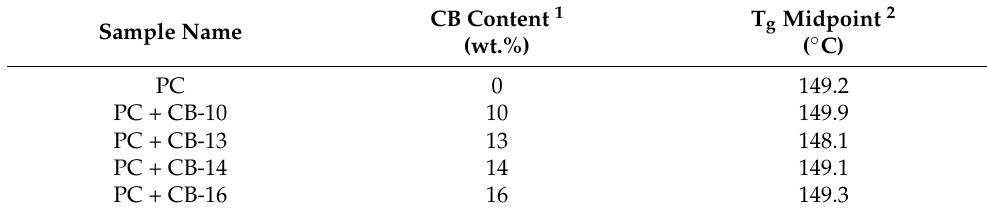
Table 1. Composition and T g midpoint, as obtained from TGA and DSC measurements.